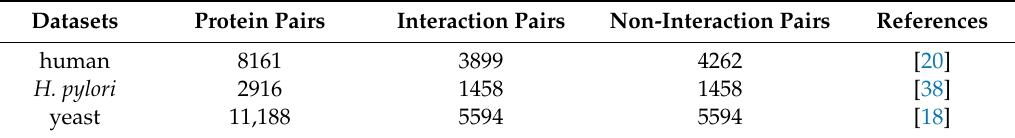
Table 6. The details of three benchmark data